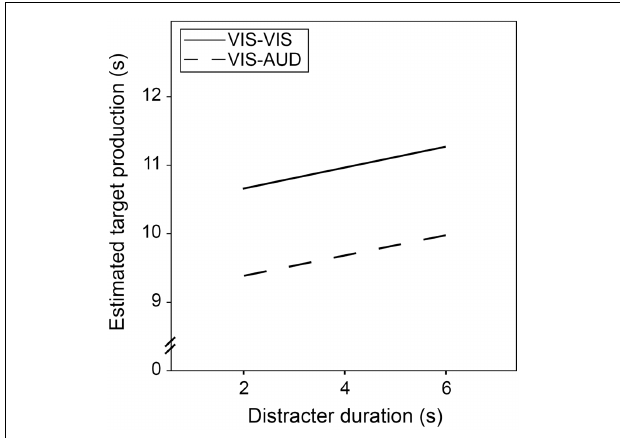
FIGURE 4 |Temporal productions of the target interval in Experiment 2, estimated by linear regression analysis. The straight line indicates estimations of temporal productions in case the distracter stimulus was presented visually, the interrupted line indicates temporal productions in case the distracter stimulus was presented auditorily. Note that temporal estimates and distracter times were displayed as untransformed values to yield better